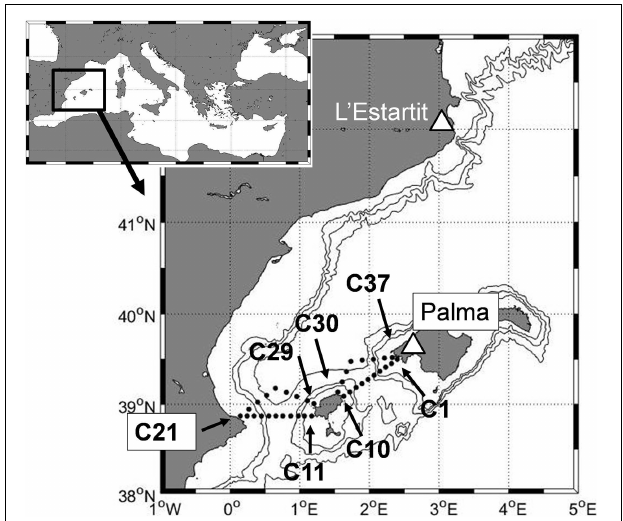
FIGURE 1 | Position of the stations monitored from 1996 to 2019 in the frame of the CANALES, CIRBAL, and RADMED projects. These stations are distributed along four sections: Mallorca South (stations C1–C10), Ibiza South (C11–C21), Ibiza North (C21–C29), and Mallorca North (C30–C37). The Mallorca South and North sections form the Mallorca Channel triangle and the Ibiza South and North form the Ibiza Channel triangle. White triangles show the position of the Palma de Mallorca tide gauge and the position of the L’Estartit coastal station.